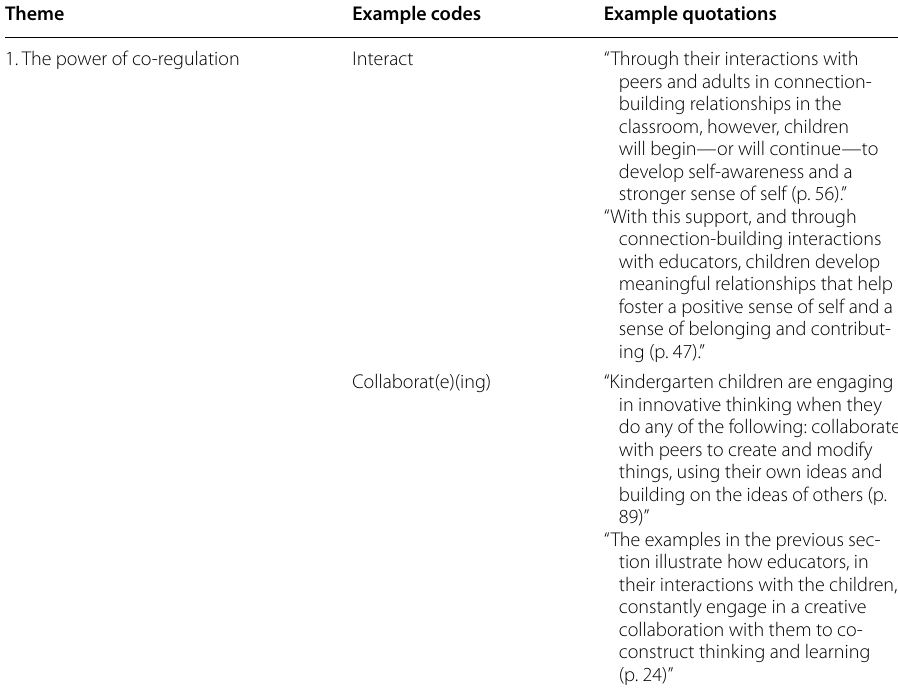
Table 2 Overview of Theme 1, example codes, and quotations